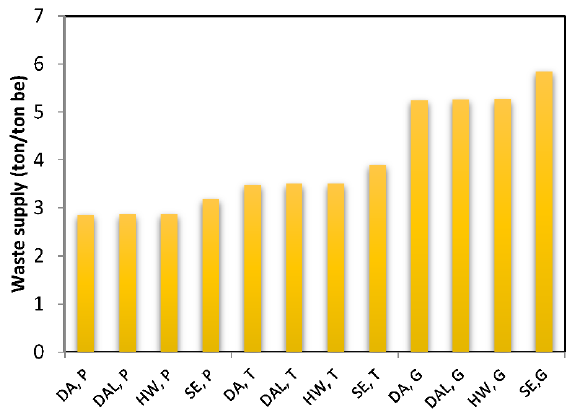
Figure 4. Waste required to produce 1 ton bioethanol; P: paper and paperboard, T: timber and wood, G: garden waste, DA: dilute acid, DAL: dilute alkali, HW: hot water, SE: steam explosion.